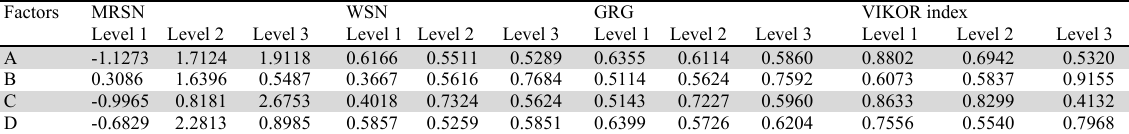
Level averages of the factors on different PPI values